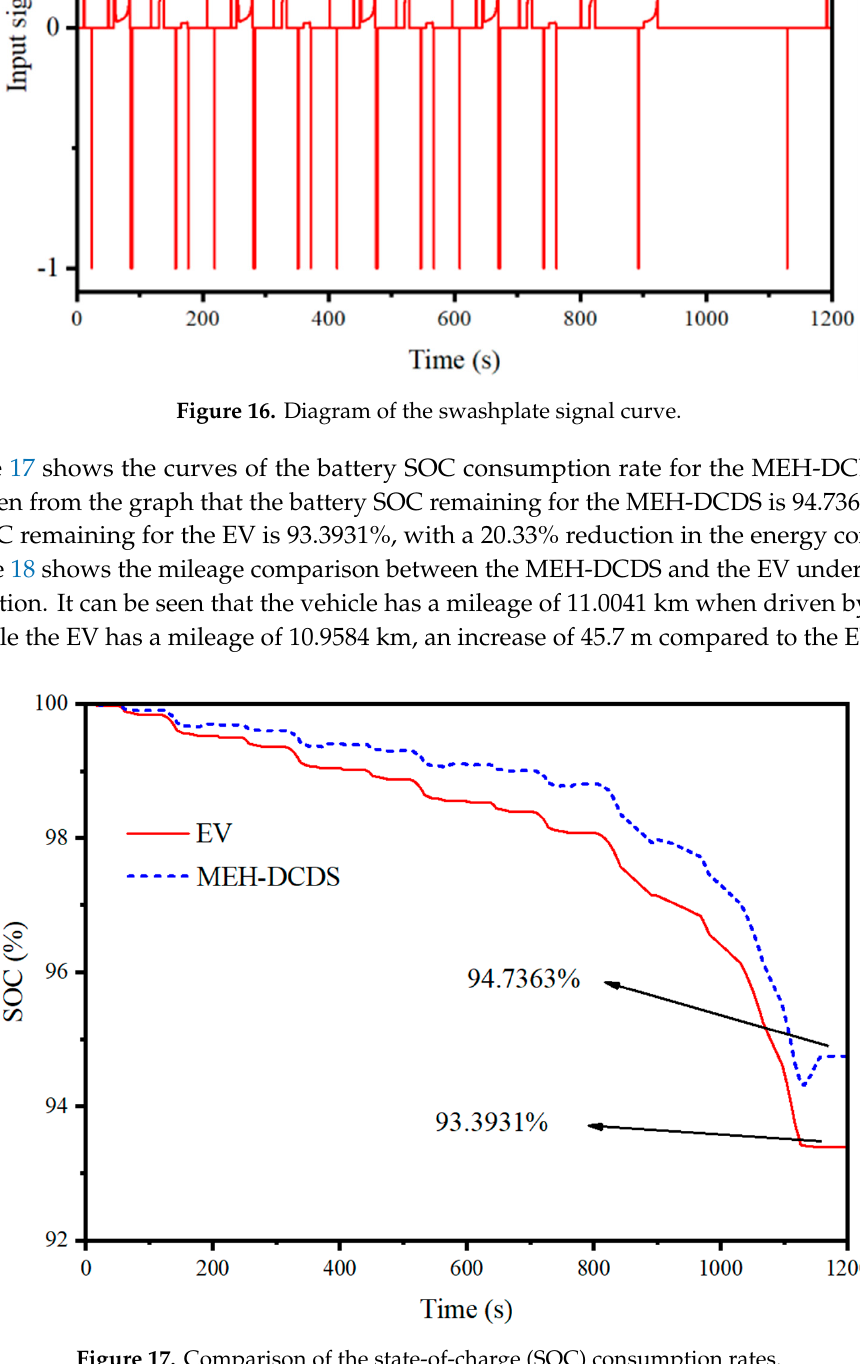
Figure 17. Comparison of the state-of-charge (SOC) consumption rates .